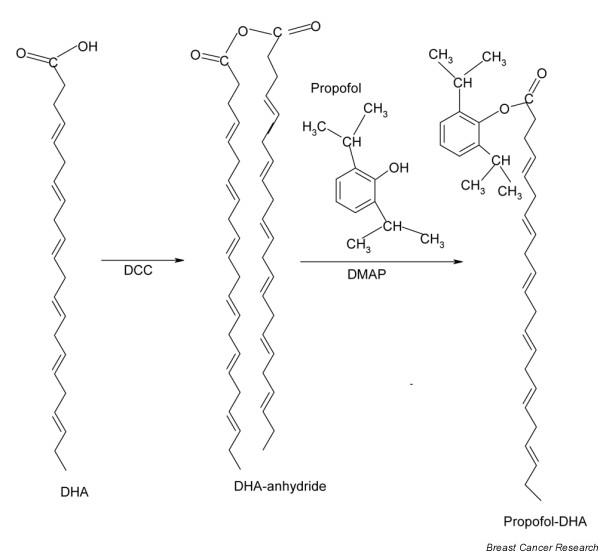
Chemical synthesis of the propofol-docosahexaenoic acid (propofol-DHA) conjugate. Synthesis was performed in two steps. First, docosahexaenoic acid anhydride (DHA-anhydride) was synthesized with a coupling reagent, N,N-dicyclohexylcarbodiimide (DCC); subsequently, conjugation of propofol with DHA was performed in the presence of 4-(dimethylamino)pyridine (DMAP).